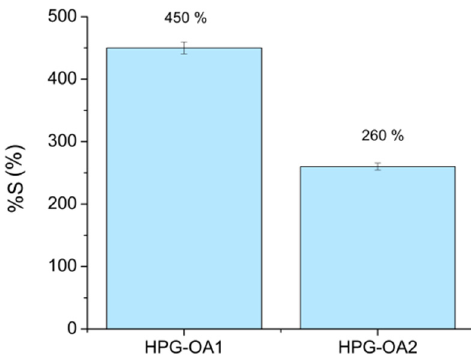
Figure 4. %S of HPG-OA1 and HPG-OA2.